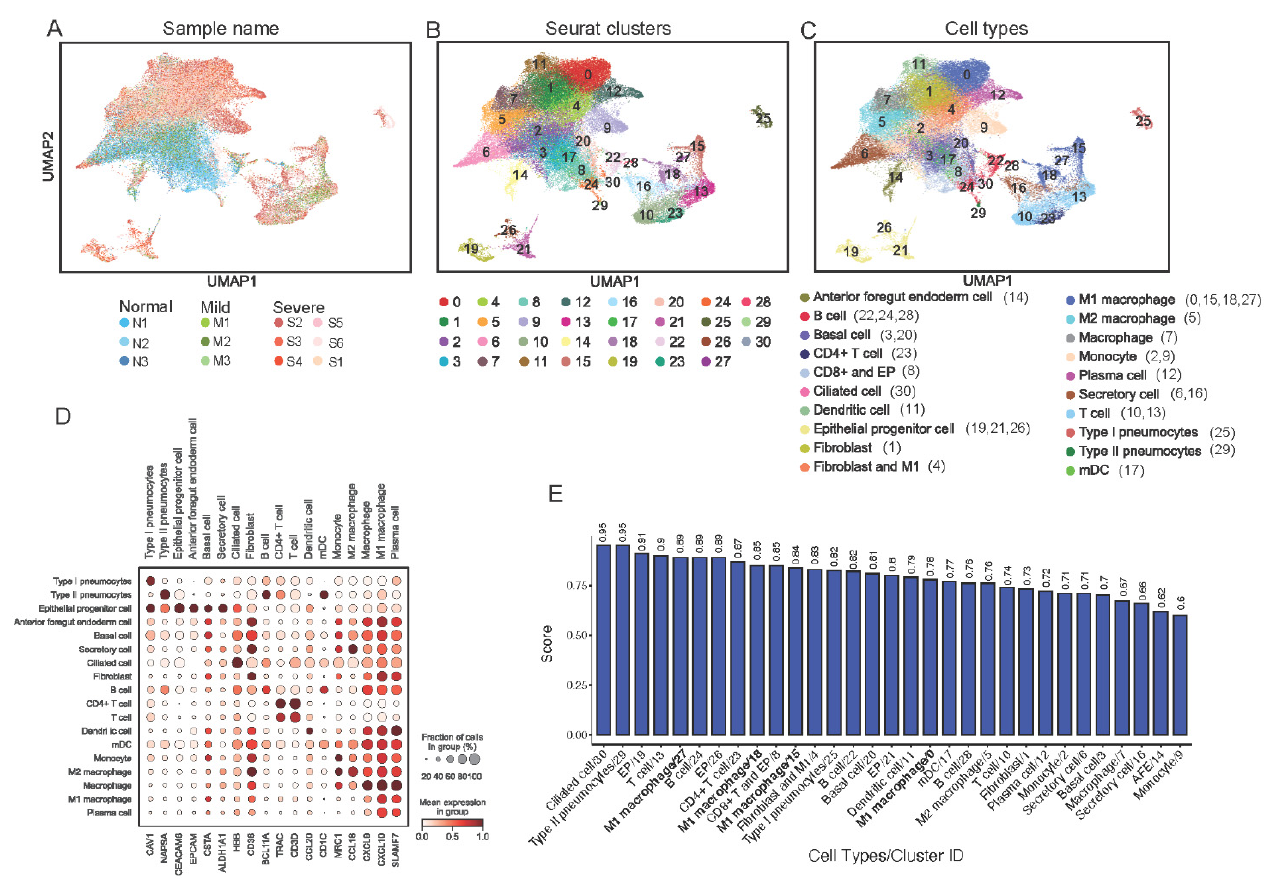
Figure 2. Alignment and clustering of gene expression from 12 patients after normalization and batch effect correction. ( A ) Cells from all 12 patients in N, M, and S groups were visualized using UMAP; ( B ) A total of 31 clusters were identified for potential cell-type assignments; ( C ) Cell types assigned to each cluster were visualized using UMAP. Cell type names and their corresponding cluster numbers (in parenthesis) were provided in legend; ( D ) Dot-plot of cell types assigned with selected gene markers. Each gene marker listed at the bottom is a selected marker for a specific cell type listed on top of the subfigure. ( E ) The AUC scores for cell type assignment to each cluster illustrated the confidence of cell type identification.